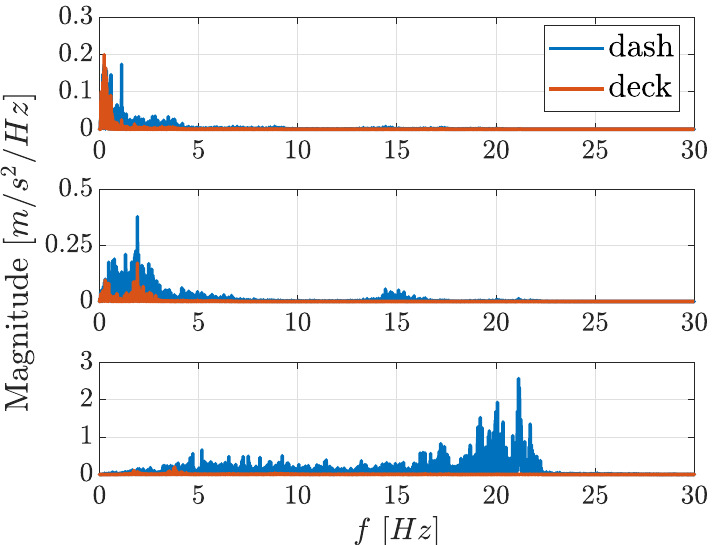
Figure 15. Acceleration spectra comparison: deck versus dashboard sensor.